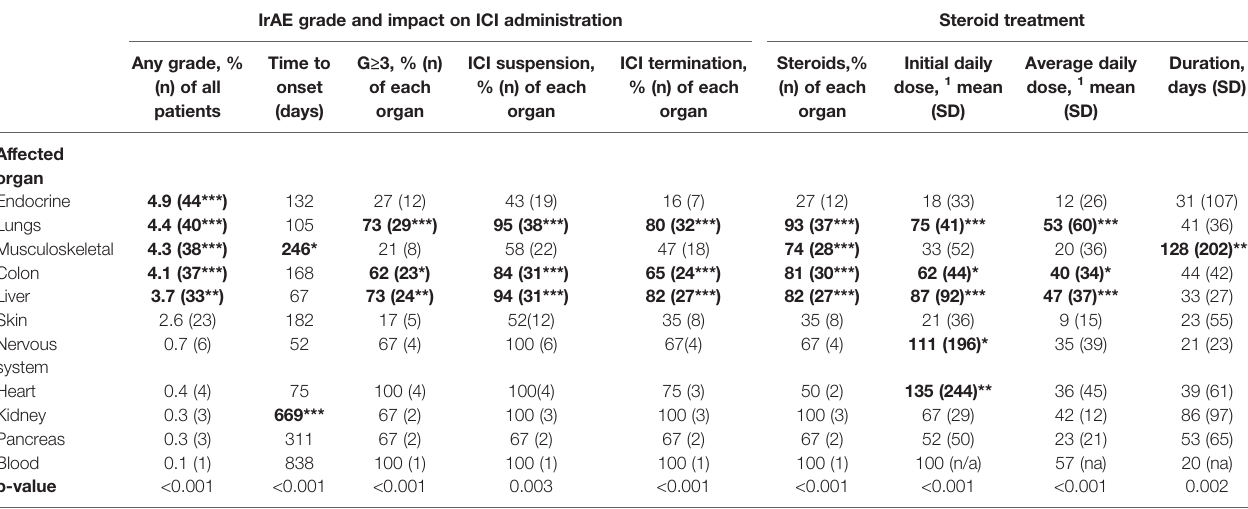
TABLE 2 | Severity, onset, and management of immune-related adverse events in stage IV non-small-cell lung cancer patients. IrAE grade and impact on ICI administration Steroid treatment Any grade, % (n) of